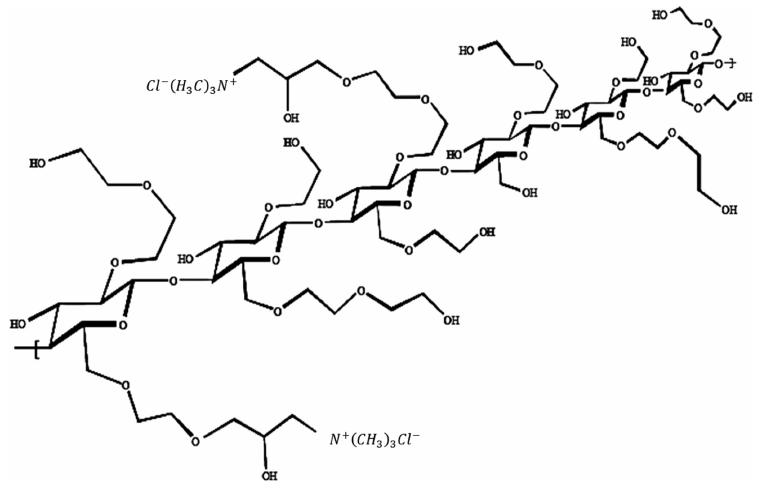
Figure 1. Generic structure of cationic hydroxyethyl cellulose (cat-HEC)